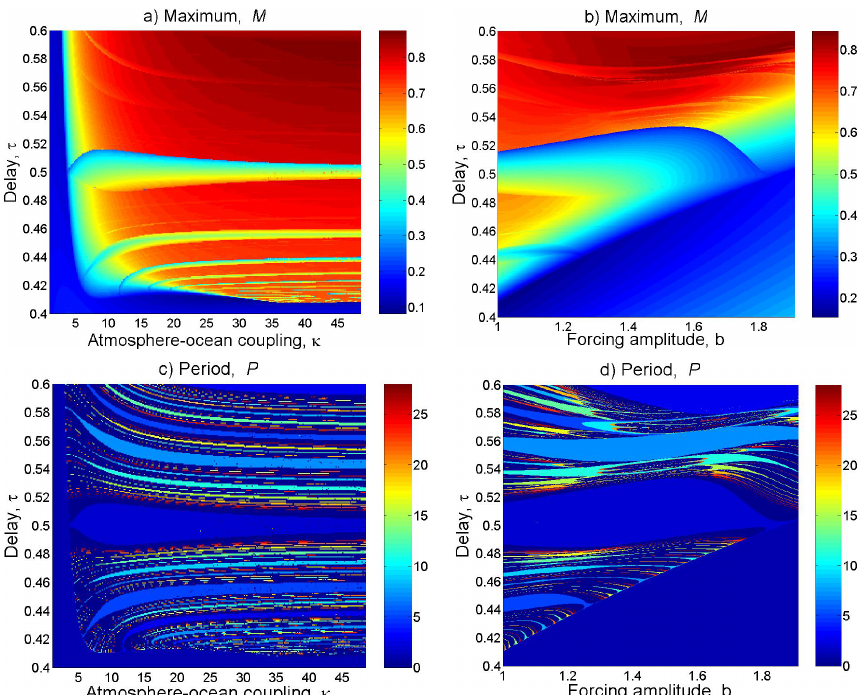
Fig. 2. Maximum and period maps for a warm initial history, φ(t) ≡ 1. (a) Maximum map, M = M(κ,τ) at b = 1; (b) maximum map, M = M(b,τ) at κ = 10; (c) period map, P = P(κ,τ) at b = 1; (d) period map, P = P(b,τ) at κ = 10. Reproduced from Ghil et al. (2008b), with kind permission of Copernicus Publications on behalf of the European Geosciences Union